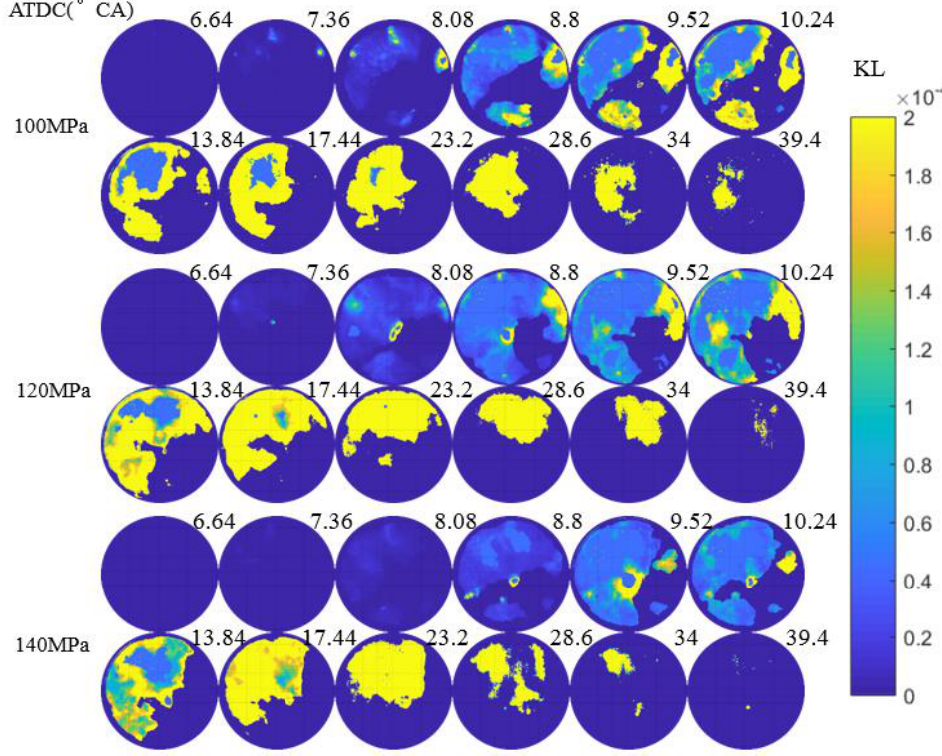
Figure 11. Spatial KL distribution of P20 at 6 °CA BTDC injection timing.